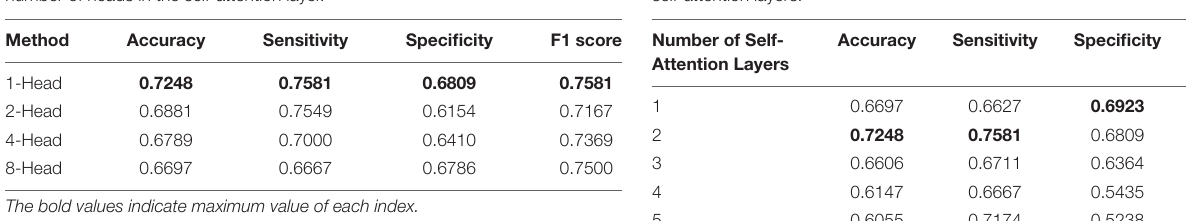
TABLE 3 | Comparison of our networks with the different number of self-attention